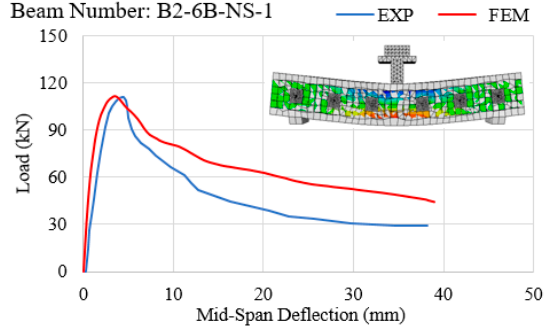
Figure 17. Load vs. mid-span deflection for B2-6B-NS-1.